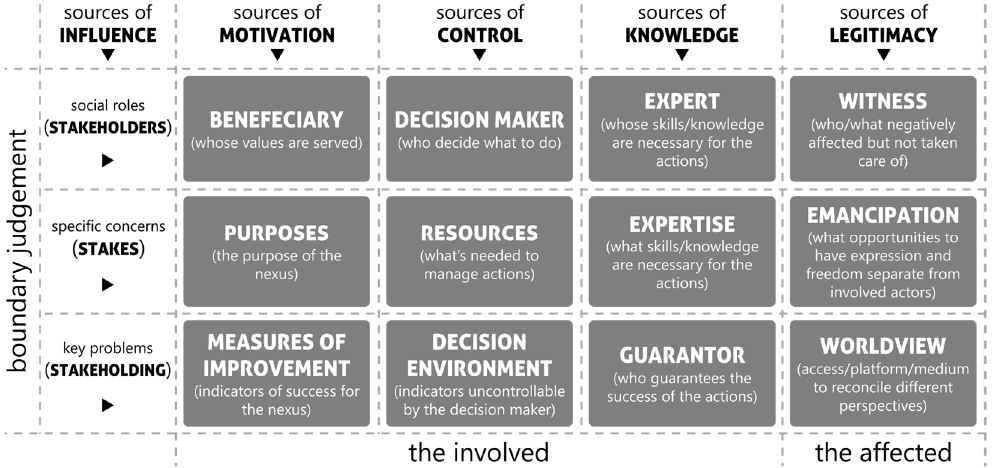
Figure 1. Theoretical framework.